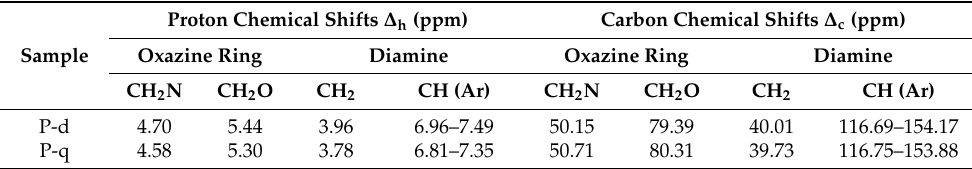
Figure 3. 1 H NMR spectrum of benzoxazine based on quamine in various solvents. Table 2. 1 Н and 13 C NMR spectroscopy data for benzoxazine monomers.